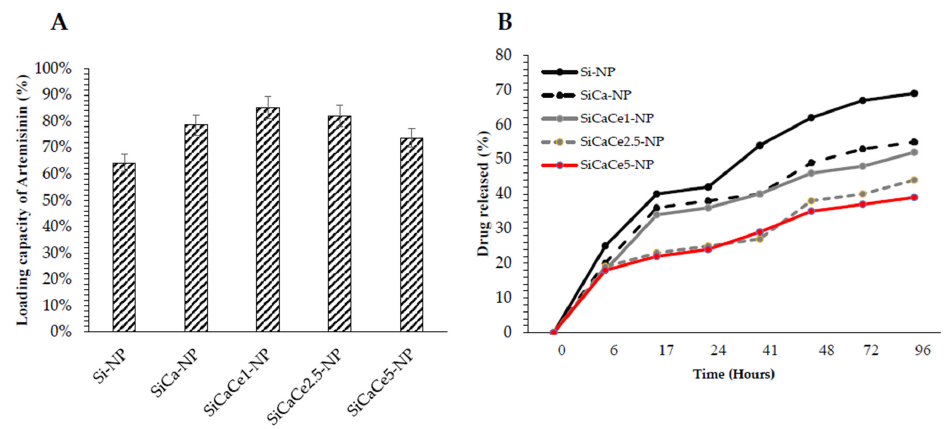
Figure 6. ( A ) Loading Capacity of Artemisinin in different groups of mesoporous NPs, ( B ) Artemisinin release capacity (%) of mesoporous NPs in a time range of up to 96 h.